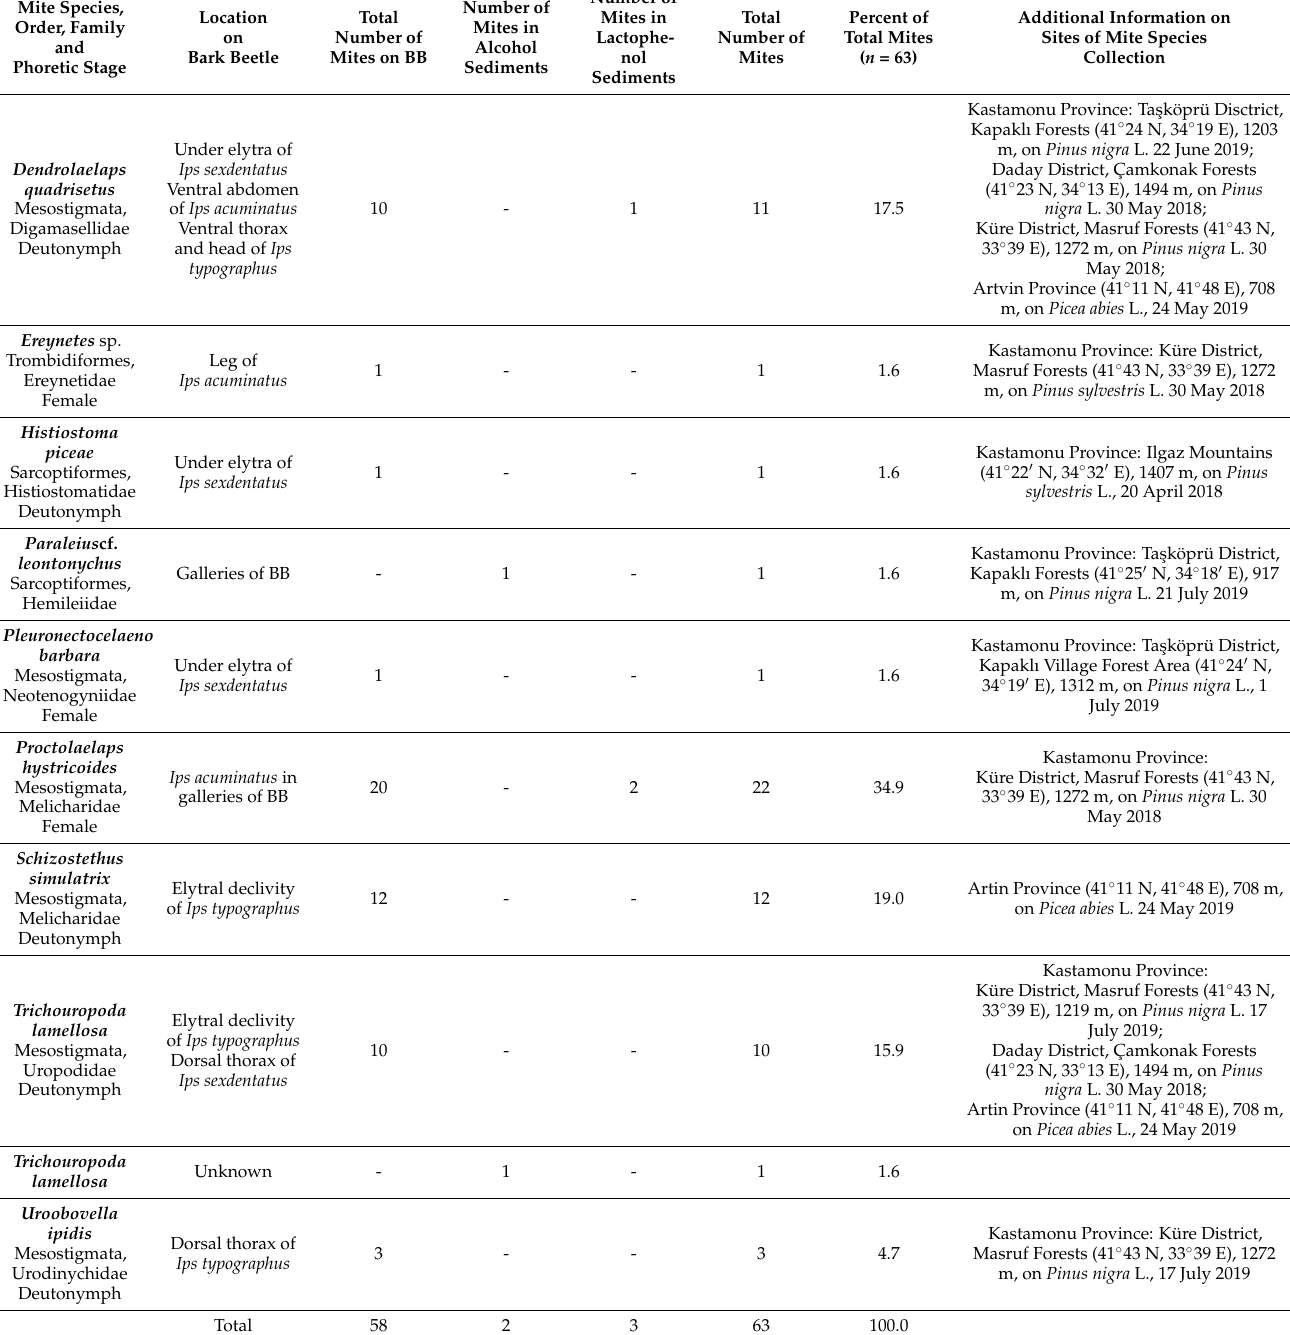
Table 1. Abundance of phoretic mites on bark beetles (BB) Ips typographus , Ips sexdentatus and Ips acuminatus collected in Northern